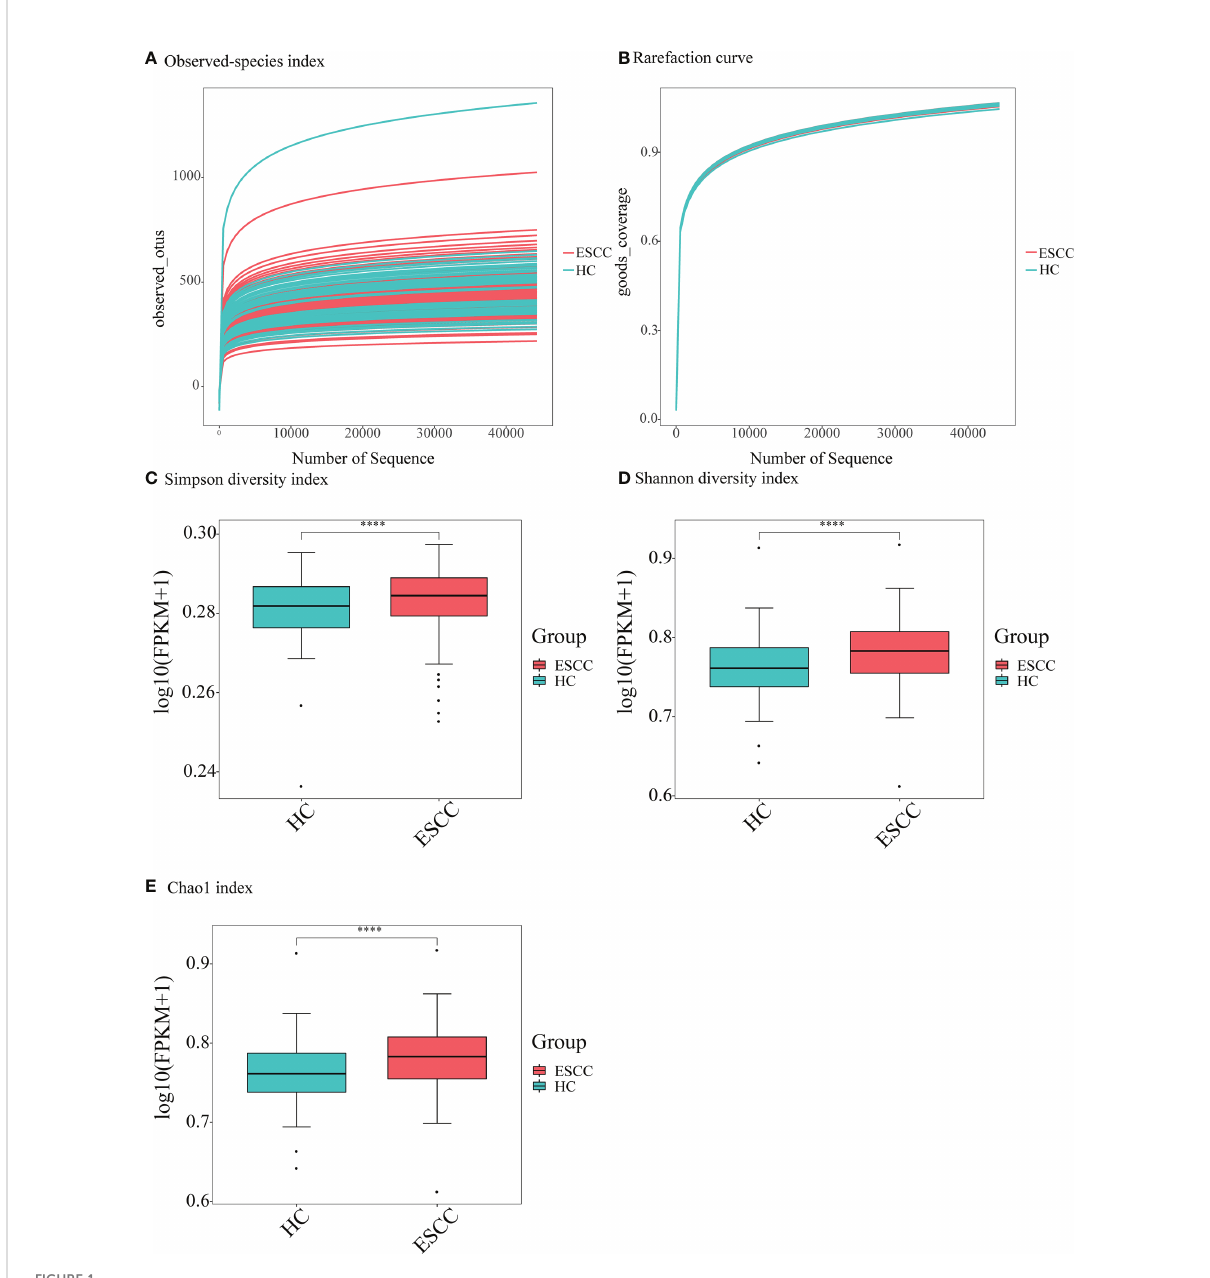
FIGURE 1 Alpha-diversity analysis showing difference in the abundance and diversity of saliva microbiota in the ESCC and healthy control (HC) groups. (A) Observed-species index; (B) rarefaction curve; (C) Simpson diversity index, (D) Shannon diversity index, and (E) Chao1 index. **** P <